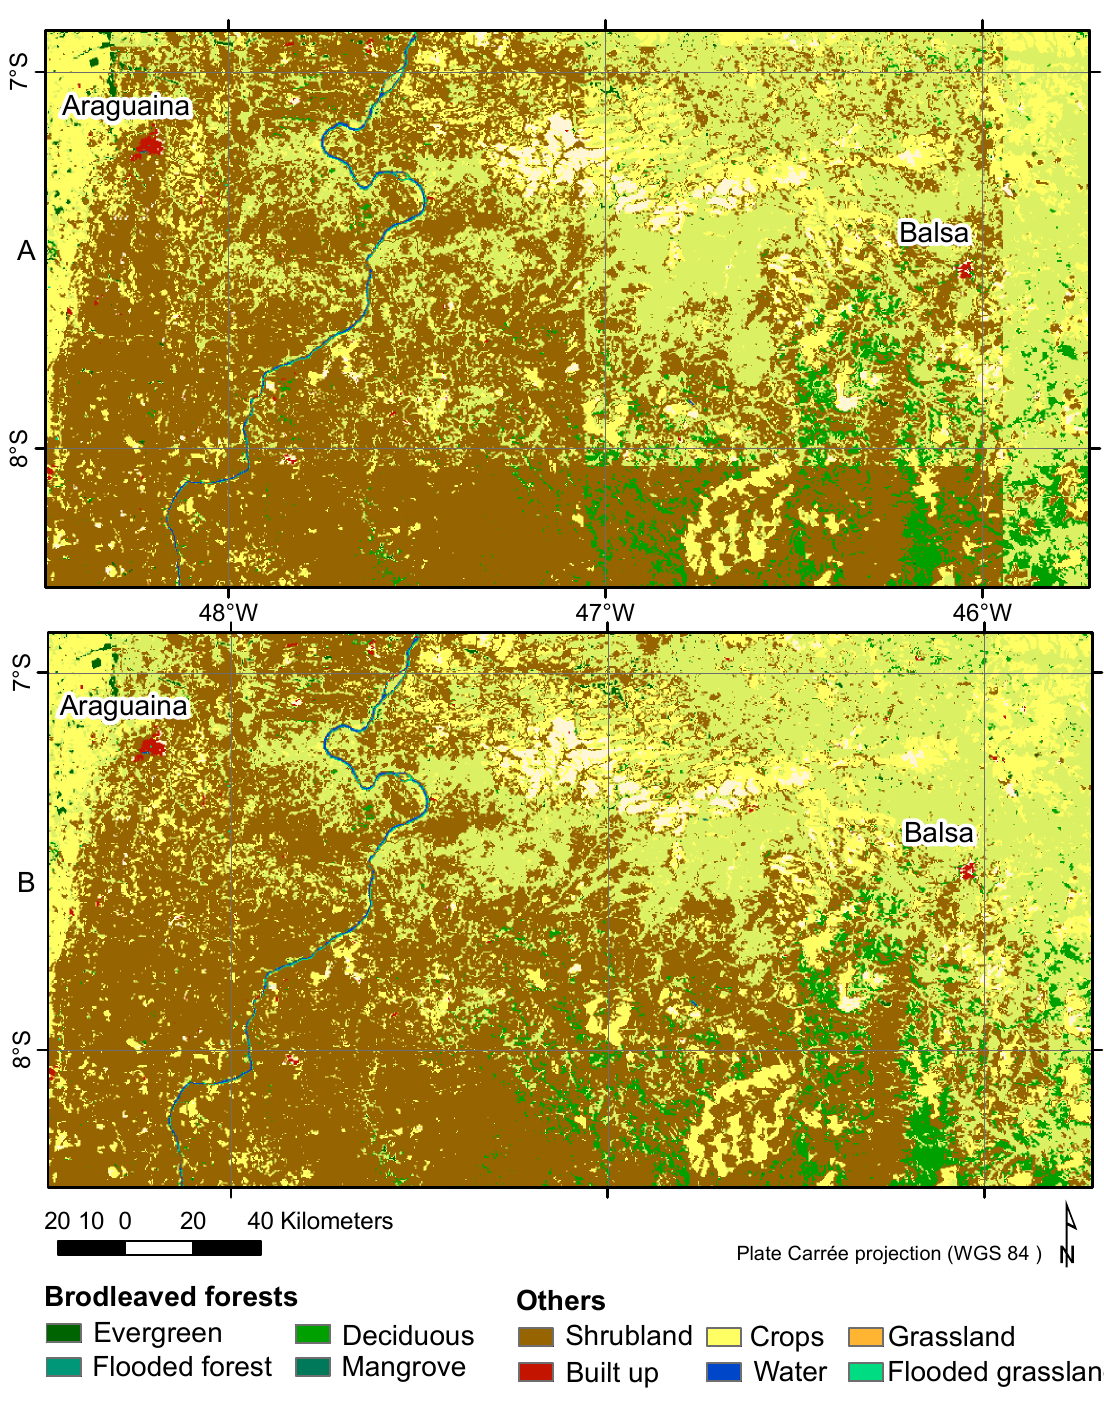
Figure 9. Detail, in the south of the South American region, of the classification results with training area of 1200 × 1200 pixels. Increasing the overlaps between successive windows removed the tiling artifacts. Processing tiles of 400 pixels ( 66% of overlap) are on top and processing tiles of 40 pixels ( 97% of overlap) at the